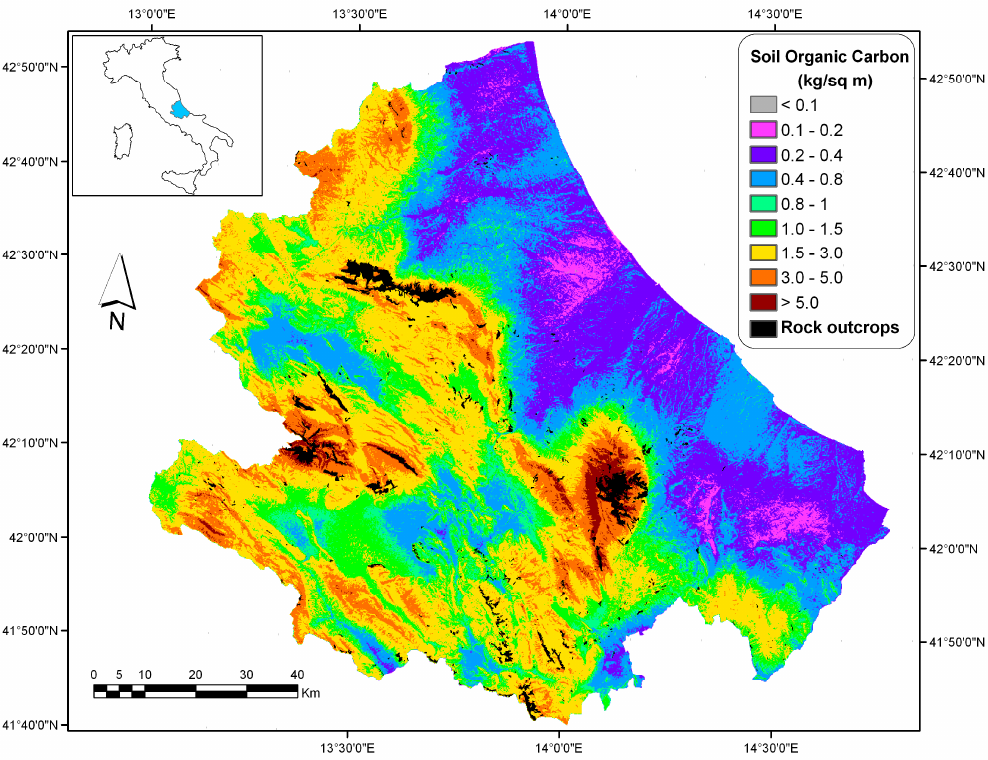
Figure 3. Soil organic carbon content predicted by RK.